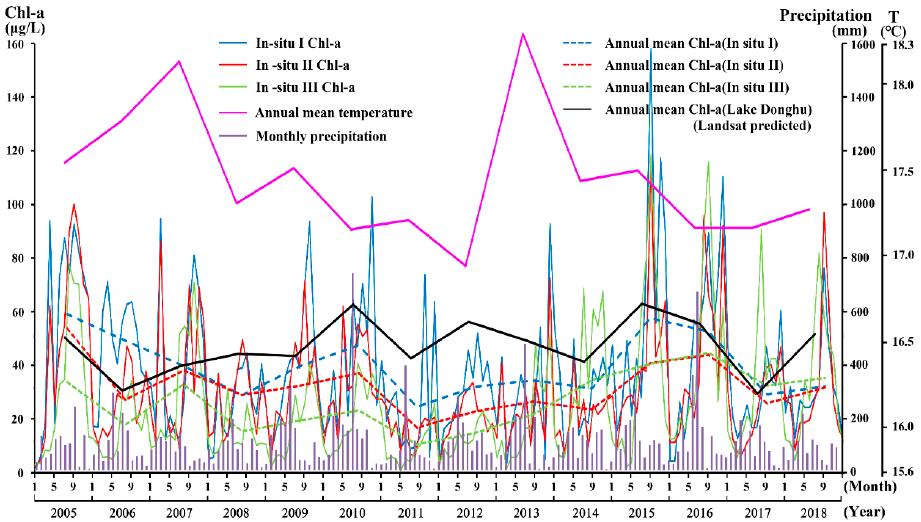
Figure 6. Comparison between the observed and predicted Chl-a and meteorological data from 2005–